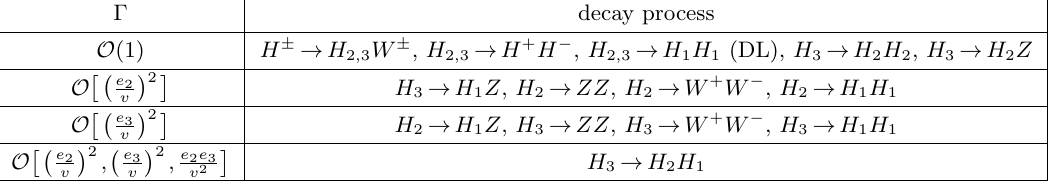
Table 6 . Possible two-body decays of heavy Higgs bosons classi(cid:12)ed according to the strength of the corresponding decay width. The (cid:12)rst row shows leading decays that exist in the AL, the second and third rows show decays the width of which is suppressed by ( e 2 =v ) 2 and ( e 3 =v ) 2 , respectively, while the fourth one contains decays with the width suppressed by max[( e 2 =v ) 2 ; ( e 3 =v ) 2 ; ( e 2 e 3 =v 2 )]. As noted in the text [cf. tables 3 and 4], if approximate alignment is achieved in the decoupling limit (DL), then the coe(cid:14)cient of the H 1 H 1 H k operator (for k = 2 ; 3) in the exact alignment limit is nonzero and hence unsuppressed.